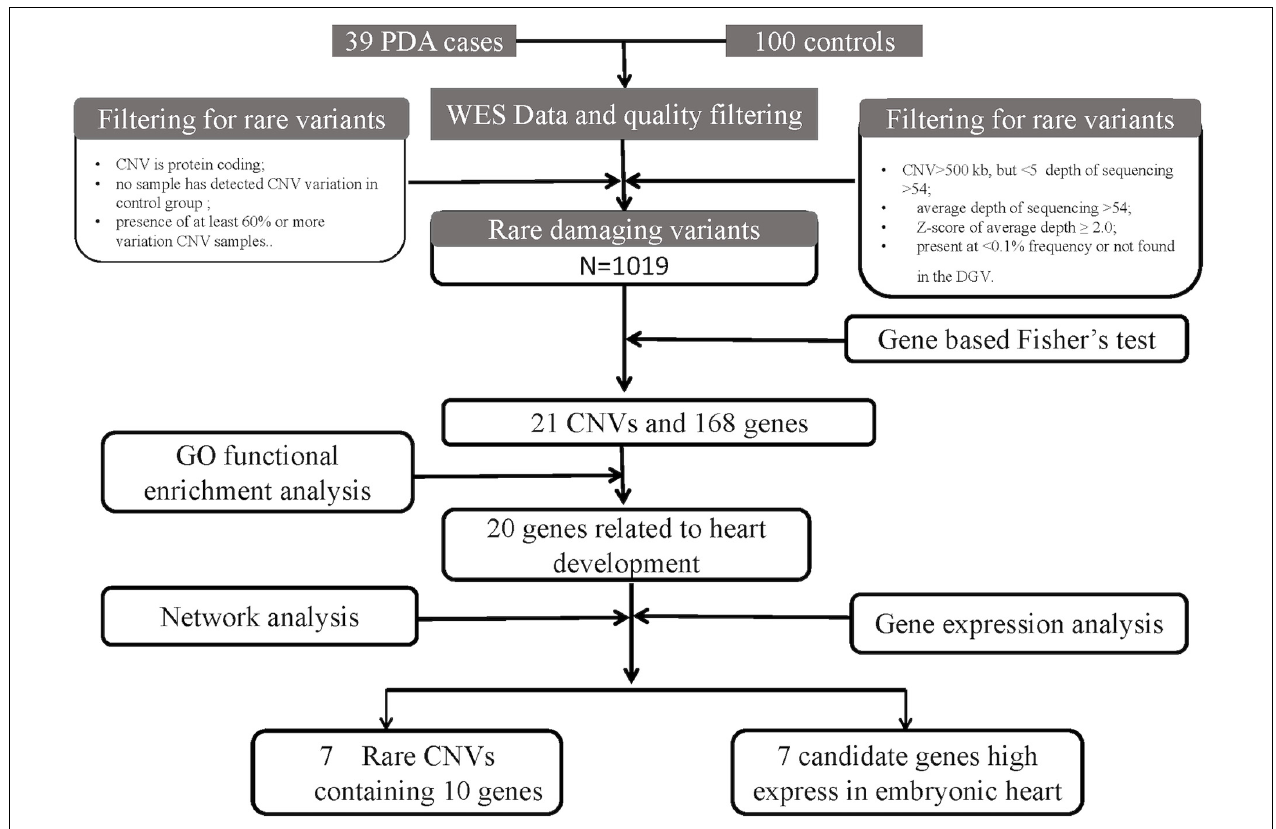
FIGURE 1 | An analytical strategy workflow of the different steps taken during whole-exome sequencing (WES) analysis with gene expression detection is shown. Gene based fisher’s test, Gene ontology (GO) functional enrichment analysis, gene network analysis and microarray analysis were performed to identify our candidate genes.